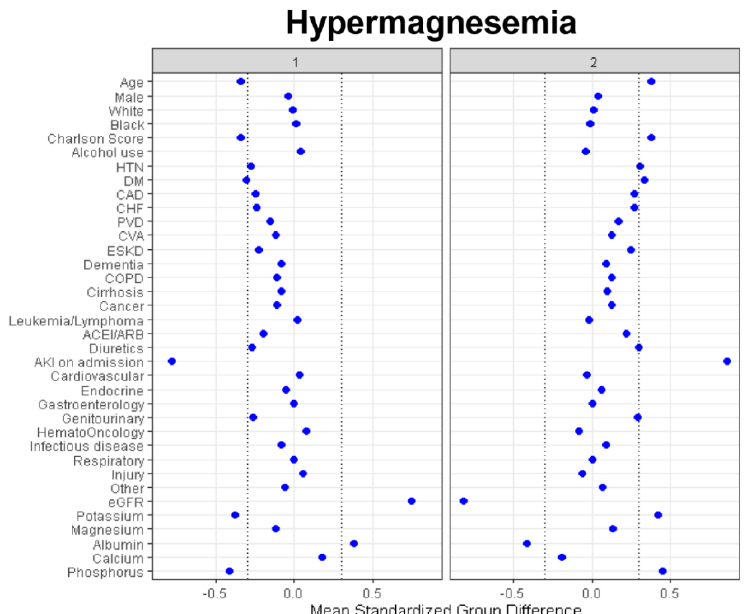
Figure 4. The standardized differences across three clusters for each of baseline parameters for patients with hypomagnesemia and hypermagnesemia. The x -axis represents the standardized differences value, and the y axis represents baseline variables. The dashed vertical lines signify the standardized differences cutoffs of < − 0.3 or >0.3. Abbreviations: AG, anion gap; AKI, acute kidney injury; BMI, body mass index; CHF, congestive heart failure; Cl, chloride; COPD, chronic obstructive pulmonary disease; CVA, cerebrovascular accident; DM, diabetes mellitus; ESKD, end stage kidney disease; GFR, glomerular filtration rate; GI, gastrointestinal; Hb, hemoglobin; HCO3, bicarbonate; K, potassium; ID, infectious disease; MI, myocardial infarction; Na, sodium; PVD, peripheral vascular disease; RS, respiratory system; SID, strong ion difference.